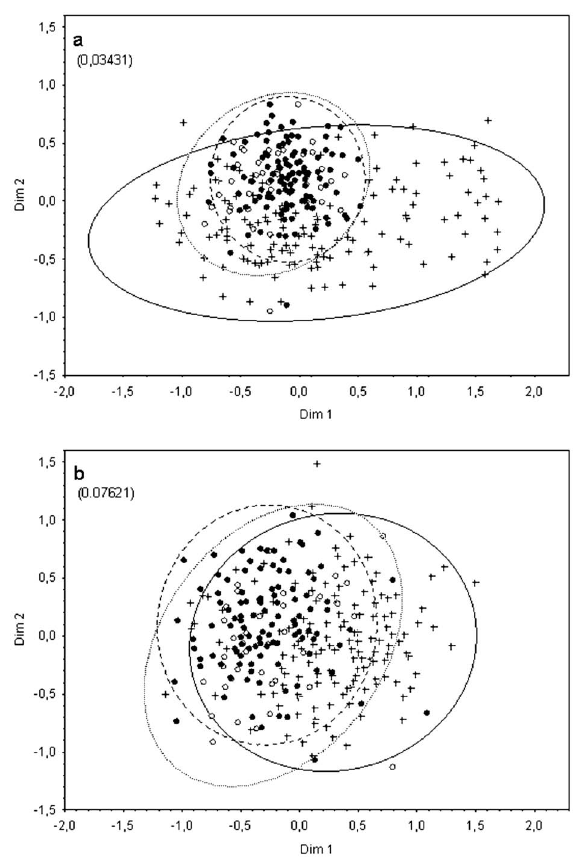
Fig . 3. – Non-metric multidimensional scaling (MDS) computed on shape variables (a) and allometry-free shape variables (b). Ellipses containing 95% of data are presented for each group. Stress values are between brackets and symbols are as in Figure